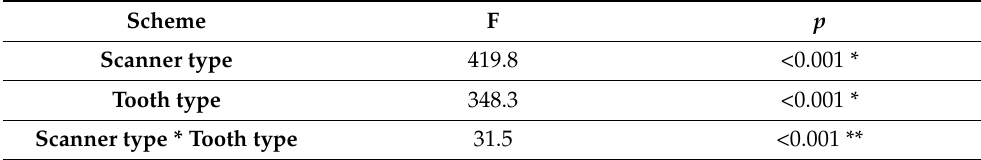
Table 2. Results from ANOVA for scanner type and tooth